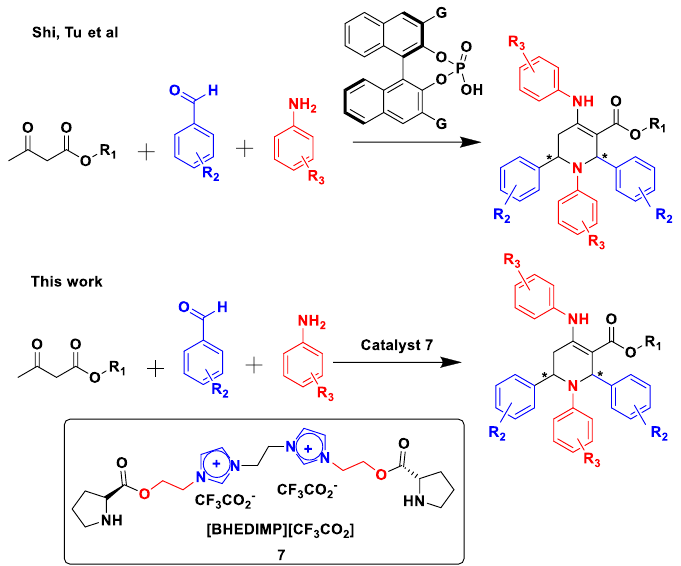
Figure 2. Comparison of catalyst for the synthesis of 1,2,5,6 tetrahydropyridines.